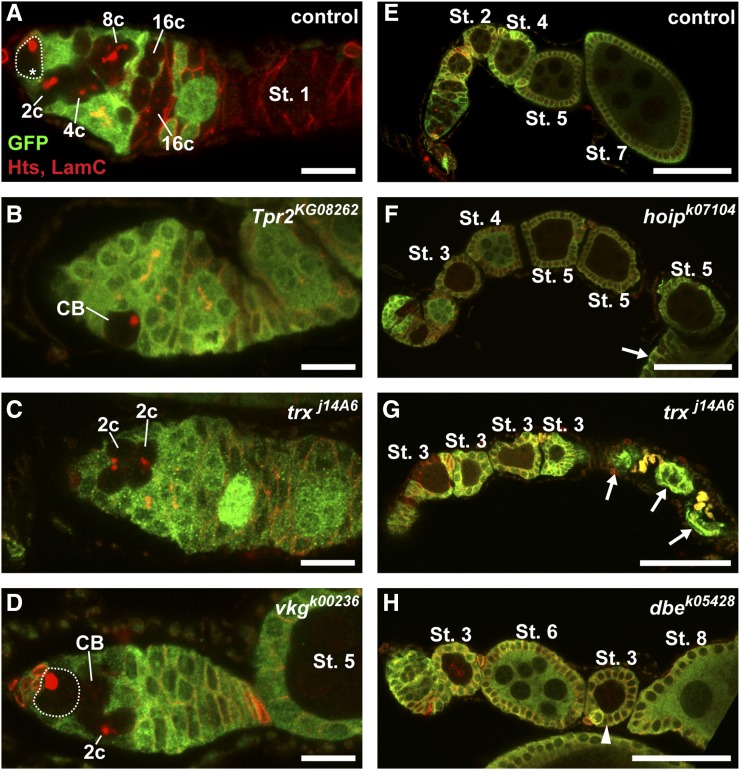
Putative ecdysone-responsive genes are required in the germline for proper cyst growth and survival. (A–H) Representative mock mosaic control (A, E) or ecdysone target gene mutant (B–D, F–H) germline-mosaic germaria (A–D) or germline-mosaic ovarioles (E–H) labeled with anti-GFP (green), anti-Hts (red; fusomes and follicle cell membranes), and anti-LamC (red; nuclear envelope of cap cells). Dotted lines demarcate GFP-negative GSCs; asterisk denotes wildtype GSC; arrows indicate dying follicles; arrowhead indicates small follicle with a mutant cyst in between two larger wildtype follicles. Oogenesis stages determined (except in the case of dying follicles) by follicle size and nurse cell nuclear morphology, as described (Spradling 1993). Scale bar, 10 µm (A–D) or 50 µm (E–H).